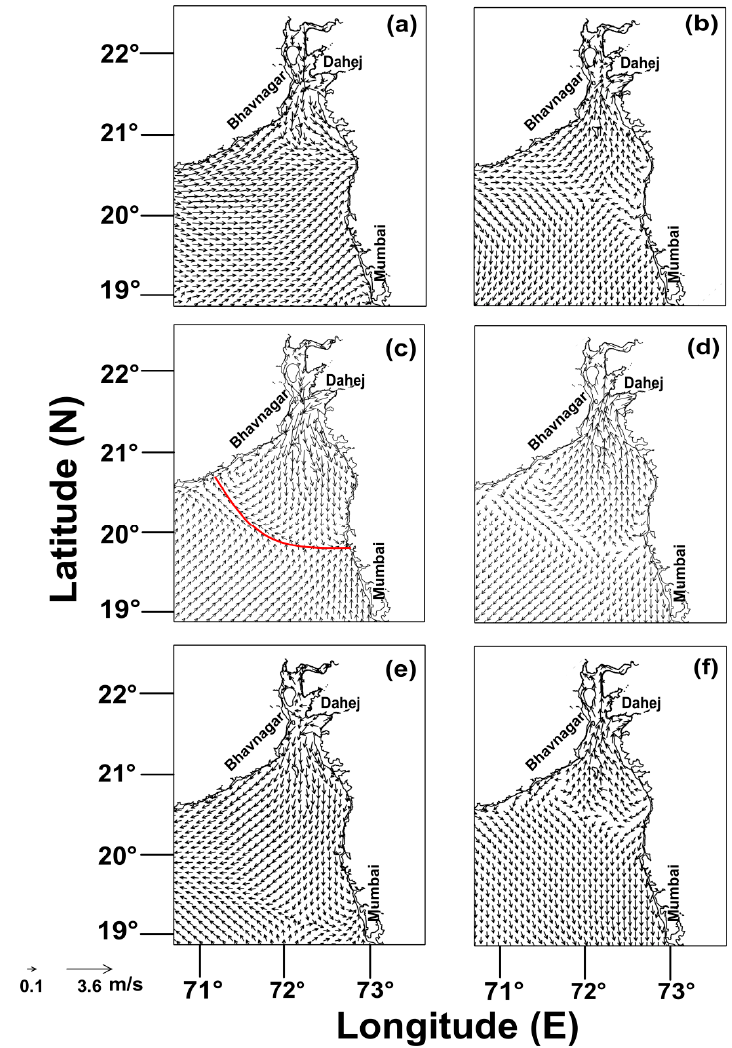
Figure 7. Circulation driven by combined action of tide and wind for various seasons in the spring tidal condition: ( a ) spring ebb for NE-monsoon, ( b ) spring flood for NE-monsoon, ( c ) spring ebb for pre-monsoon, ( d ) spring flood for pre-monsoon, ( e ) spring ebb for SW-monsoon, ( f ) spring flood for SW-monsoon; red line denotes the barrier.